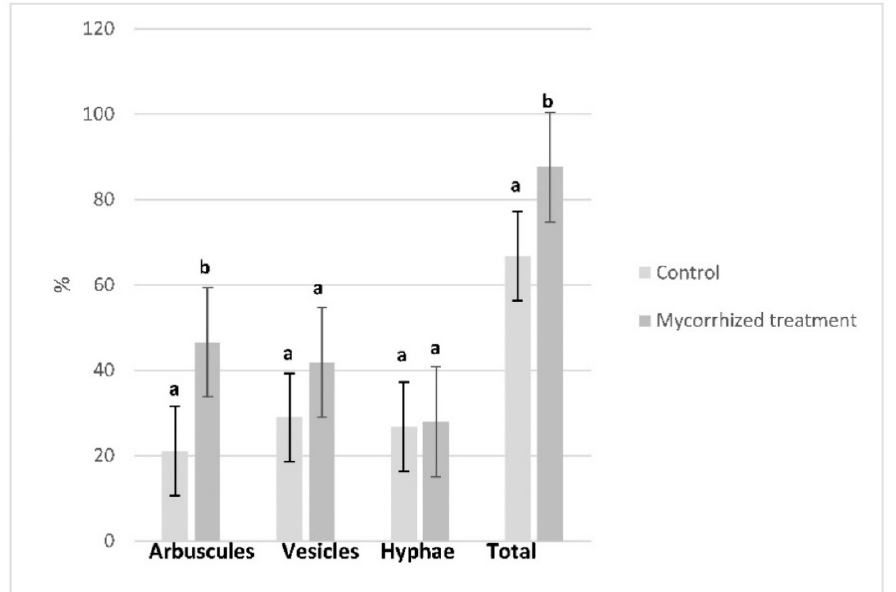
Figure 1. Percentage of arbuscules, vesicles, hyphae only, and total colonization of AMF in control and mycorrhized treatments. Means with different letters are significantly different within treatments (mean separation by Bonferroni correction at p ≤ 0.05). Error bars represent standard deviation.